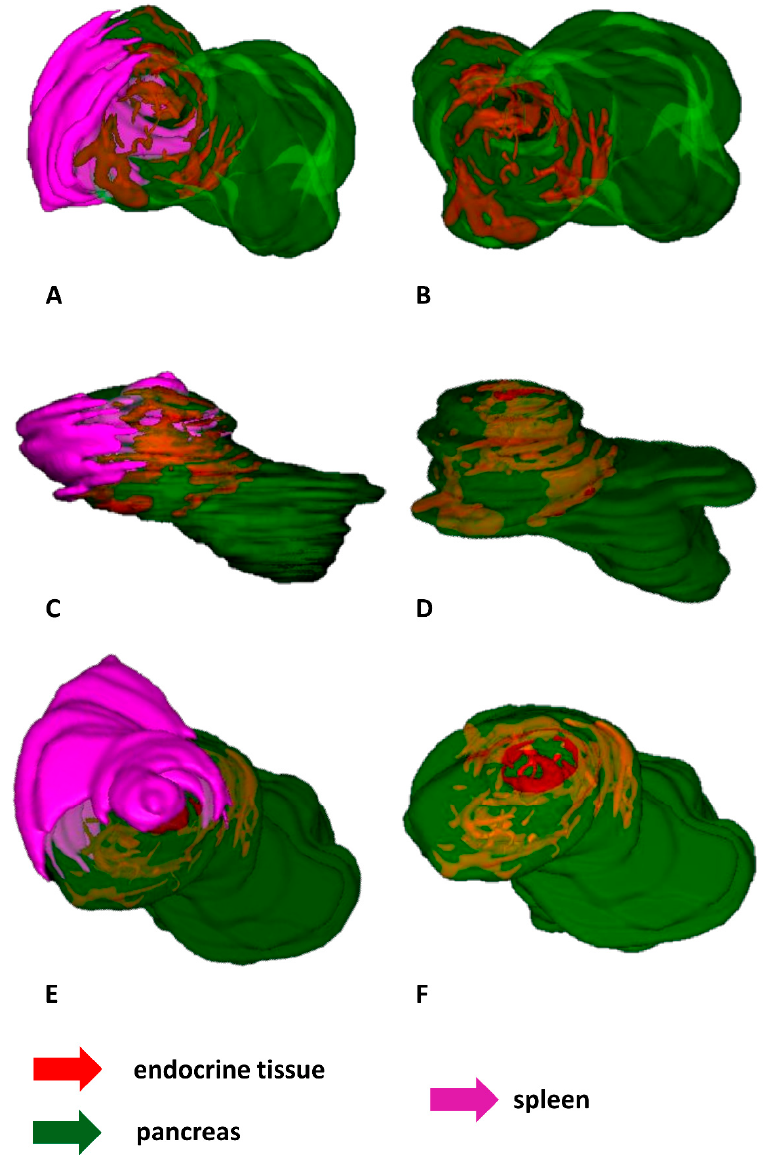
Figure 5. 3D reconstructions of the endocrine tissue arrangement within pancreas of the grass snake embryos at developmental stages I–III. Note that endocrine tissue is localized only in the dorsal part of pancreas. ( A ) Bottom view. Pancreas with spleen visualized. ( B ) Top view. Only pancreas visualized. ( C ) Lateral view with spleen and pancreas. ( D ) Lateral view with pancreas. ( E ) Top view with spleen and pancreas. ( F ) Top view with pancreas.